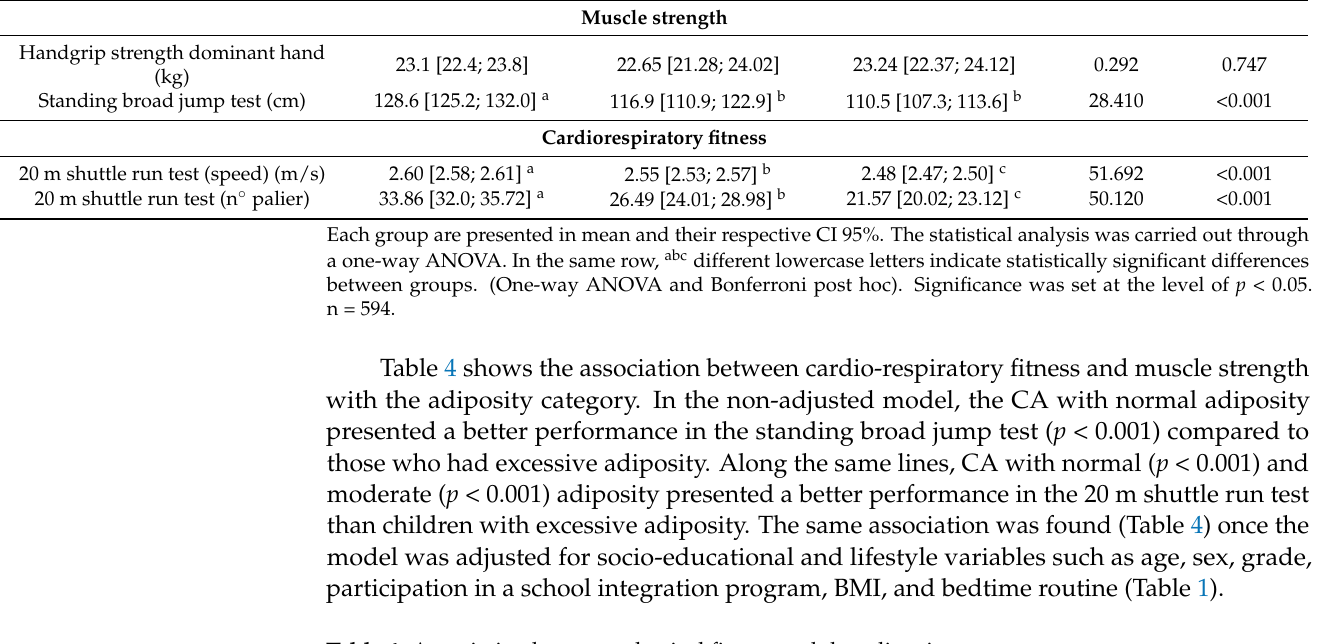
Table 4. Association between physical fitness and the adiposity